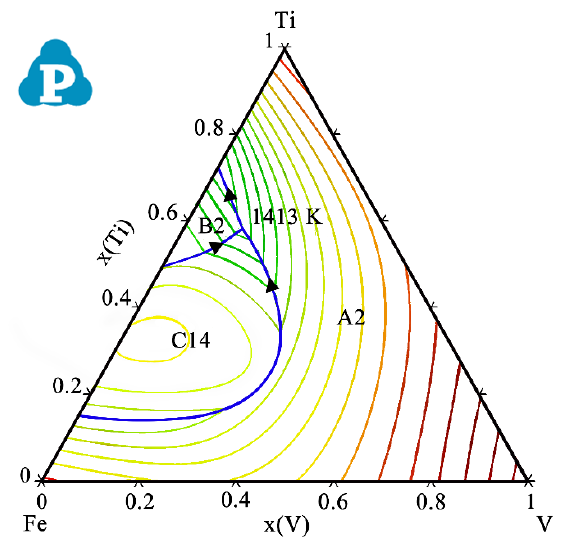
Figure 7. Calculated isothermal sections at ( a ) 1273 K and ( b ) 1473 K in the Ti-Fe-V system in com- parison with experimental data [66].